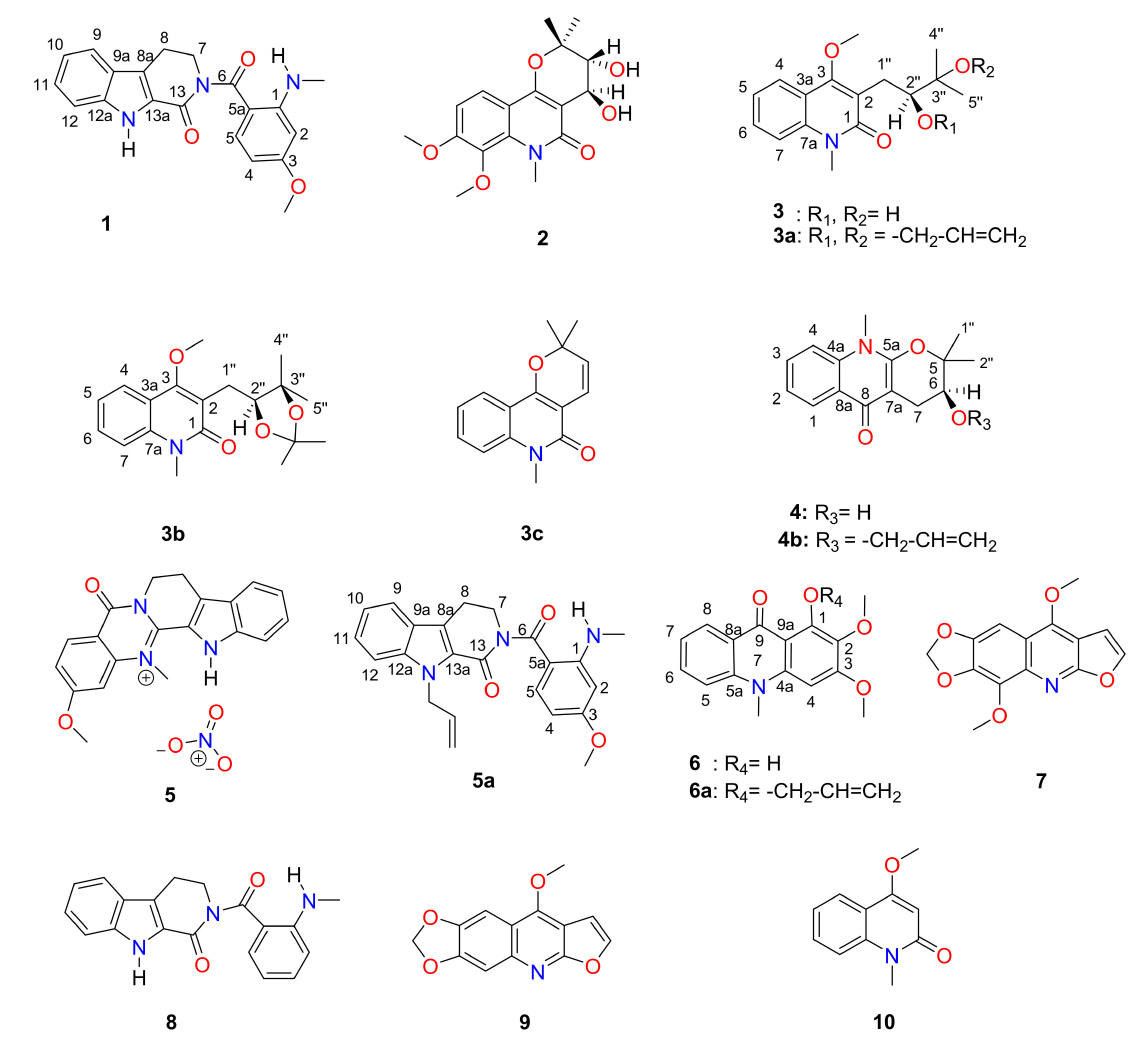
Figure 1. Chemical structures of compounds 1 – 10